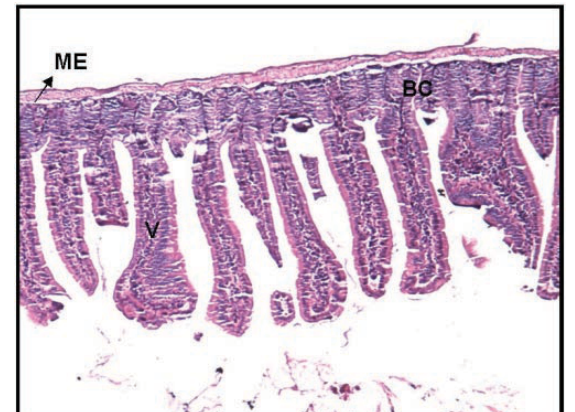
Figure 5. Photomicrograph of the small intestine of a mouse fed with probiotic (Group III) showing an intact mucosal epithelium (ME), well-preserved morphology of the basal crypts (BC) and microvilli (V), (H & E stain, 100